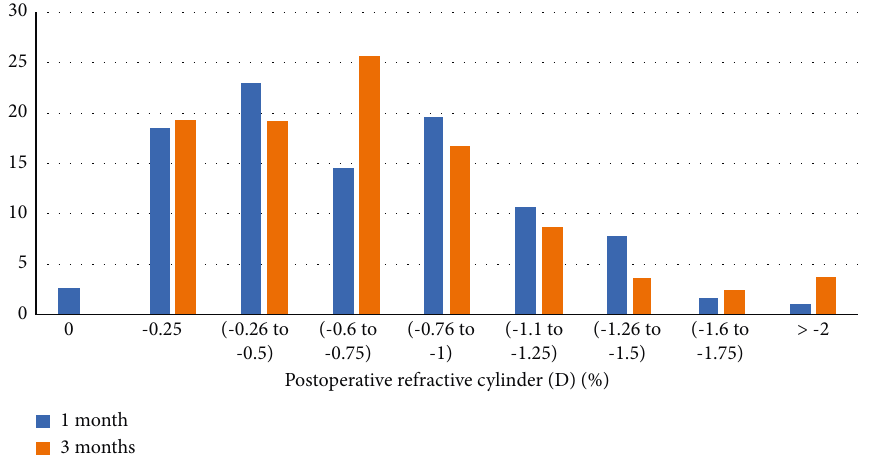
Figure 2: Postoperative cylinder.